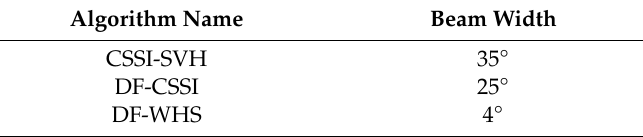
Table 2. Beam widths of the three algorithms in the 200–900 Hz processing frequency